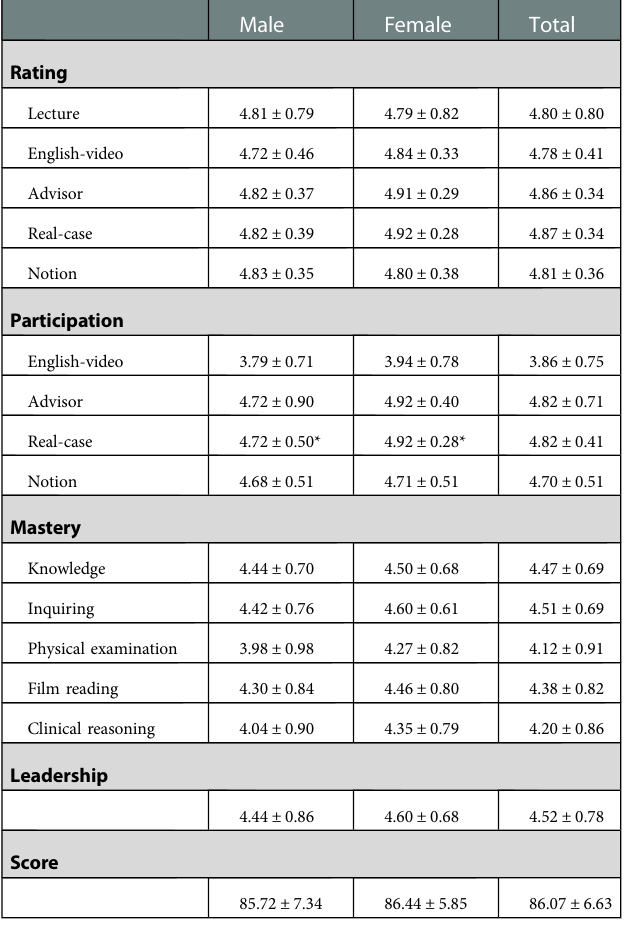
TABLE 1 Subgroup feedback of the clerkship class based on